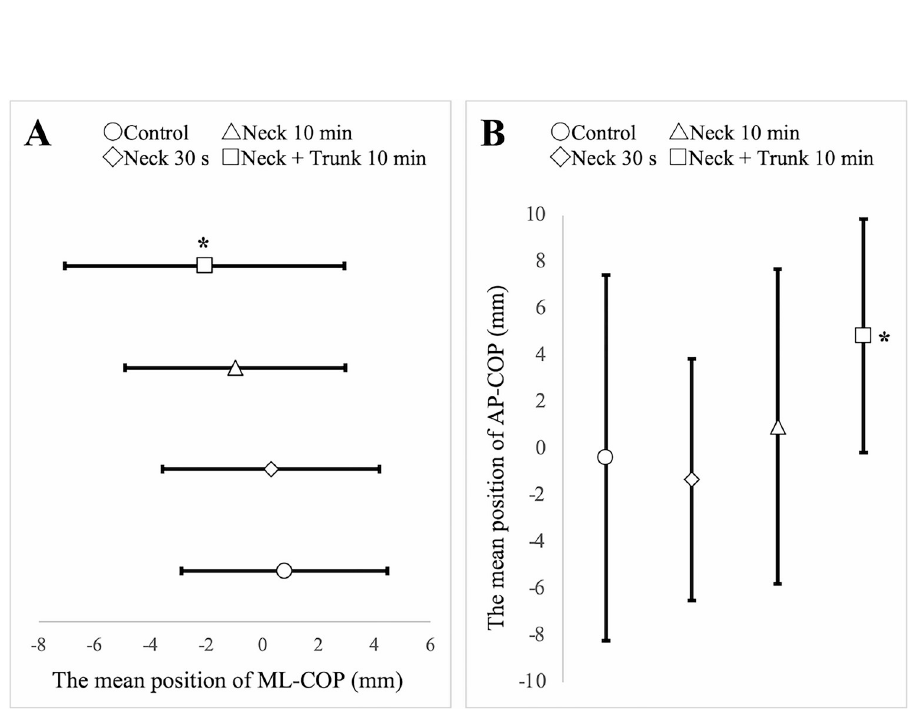
Fig 3. Differences in the mean position of COP before and after vibration (n = 24). Error bars indicate the standard error. A. The results of Dunnett’s test on the mean position of ML-COP with closed eyes. Positive values indicate a rightward deviation, whereas negative values indicate a leftward deviation on the mediolateral plane. B. The results of Dunnett’s test on the mean position of AP-COP with closed eyes. Positive values indicate an anterior deviation, whereas negative values indicate a posterior deviation on the anteroposterior plane. Asterisks indicate significant differences compared with the control condition, Dunnett’s test: p < 0.05. ML-COP, mediolateral-center of pressure; AP-COP, anteroposterior-center of